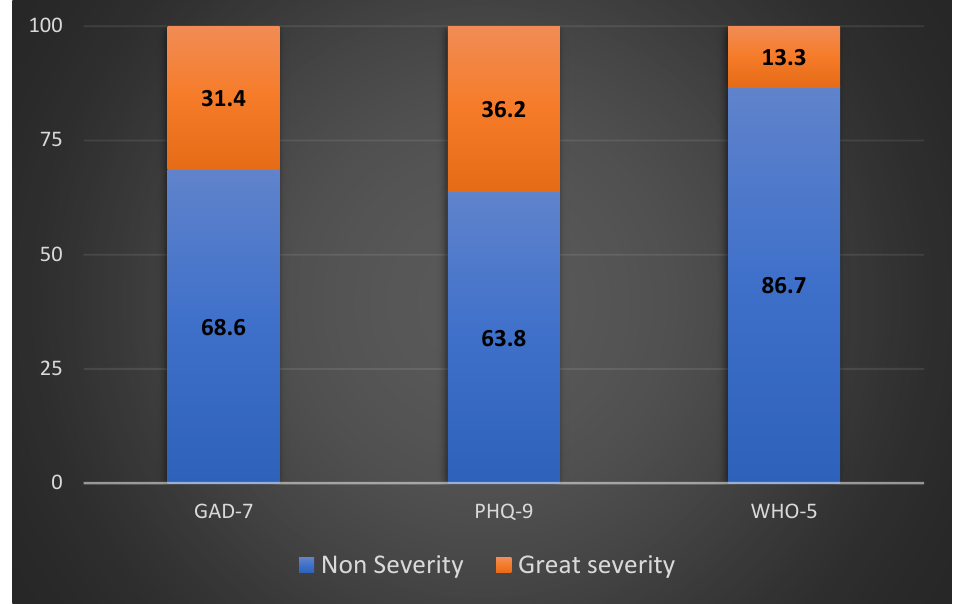
Figure 1. Frequency distribution (%) of GAD-7, PHQ-9, and WHO-5 scores among enrolled participants. “Non-severity” includes scores within normal limits. “Great severity” includes scores at pathological limits, regardless of severity grade.